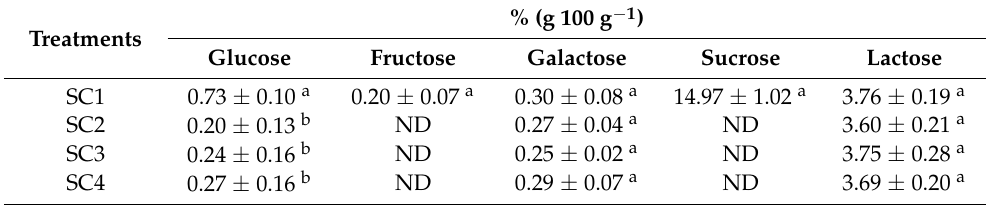
SC1: control without artificial sugar; SC2: ice cream with stevia; SC3: ice cream with sucralose; SC4: ice cream with sorbitol; ND: not detected; a and b : means with different superscript letters within the same column differ significantly ( p <